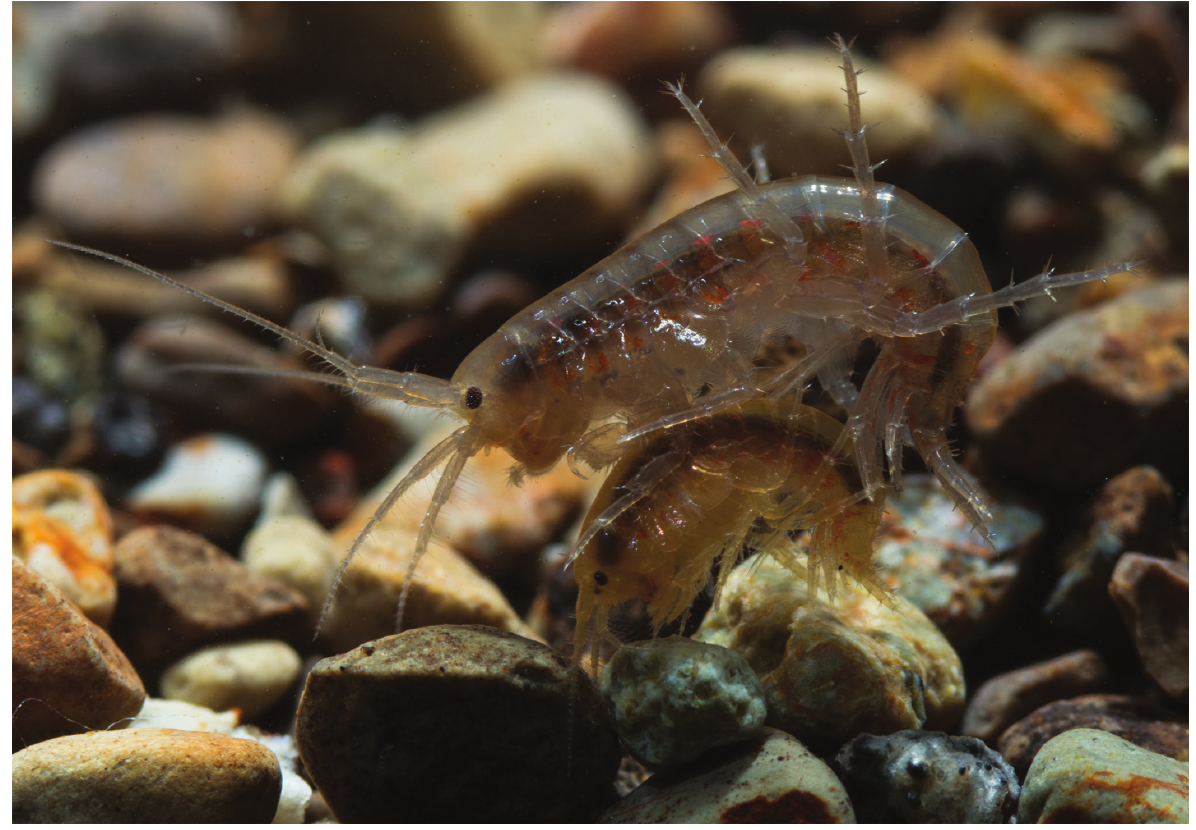
Figure 8. Jesogammarus bousfieldi sp. n., not preserved, precopula pair (male: upper, female: lower). Photographed by Ryu